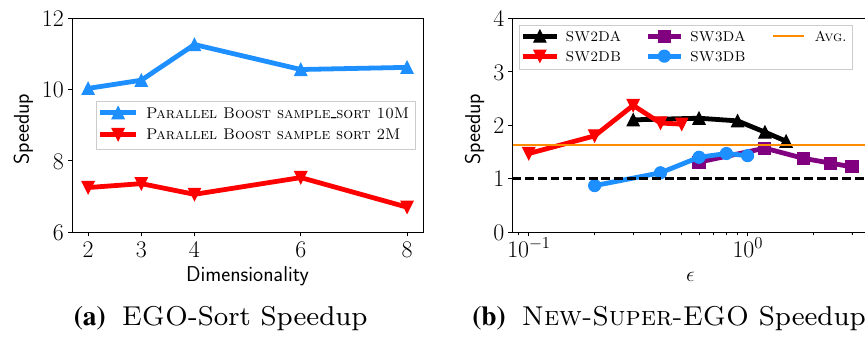
Fig. 7 a Speedup to EGo -Sort our exponentially distrib- uted synthetic datasets using SampLE _ Sort from the Boost library over QSort from the C = 0 standard library. S – 9.39K = 0 and S – 1.99K on the 2M and 10M points datasets, respectively. b Speedup of n Ew - S upEr -EGo over S upEr -EGo on the SW- real-world datasets. Results from Platform